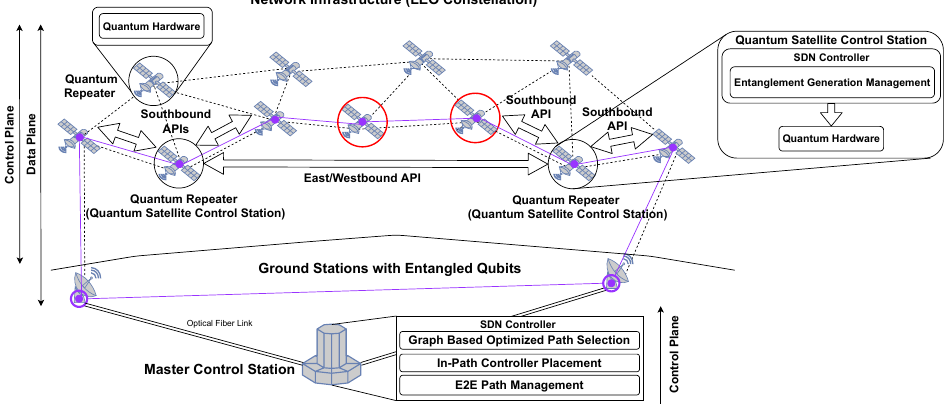
Figure 2. Quantum SDN backbone architecture. A Bell pair is generated between GSs through operations driven by the controllers embedded in the LEO